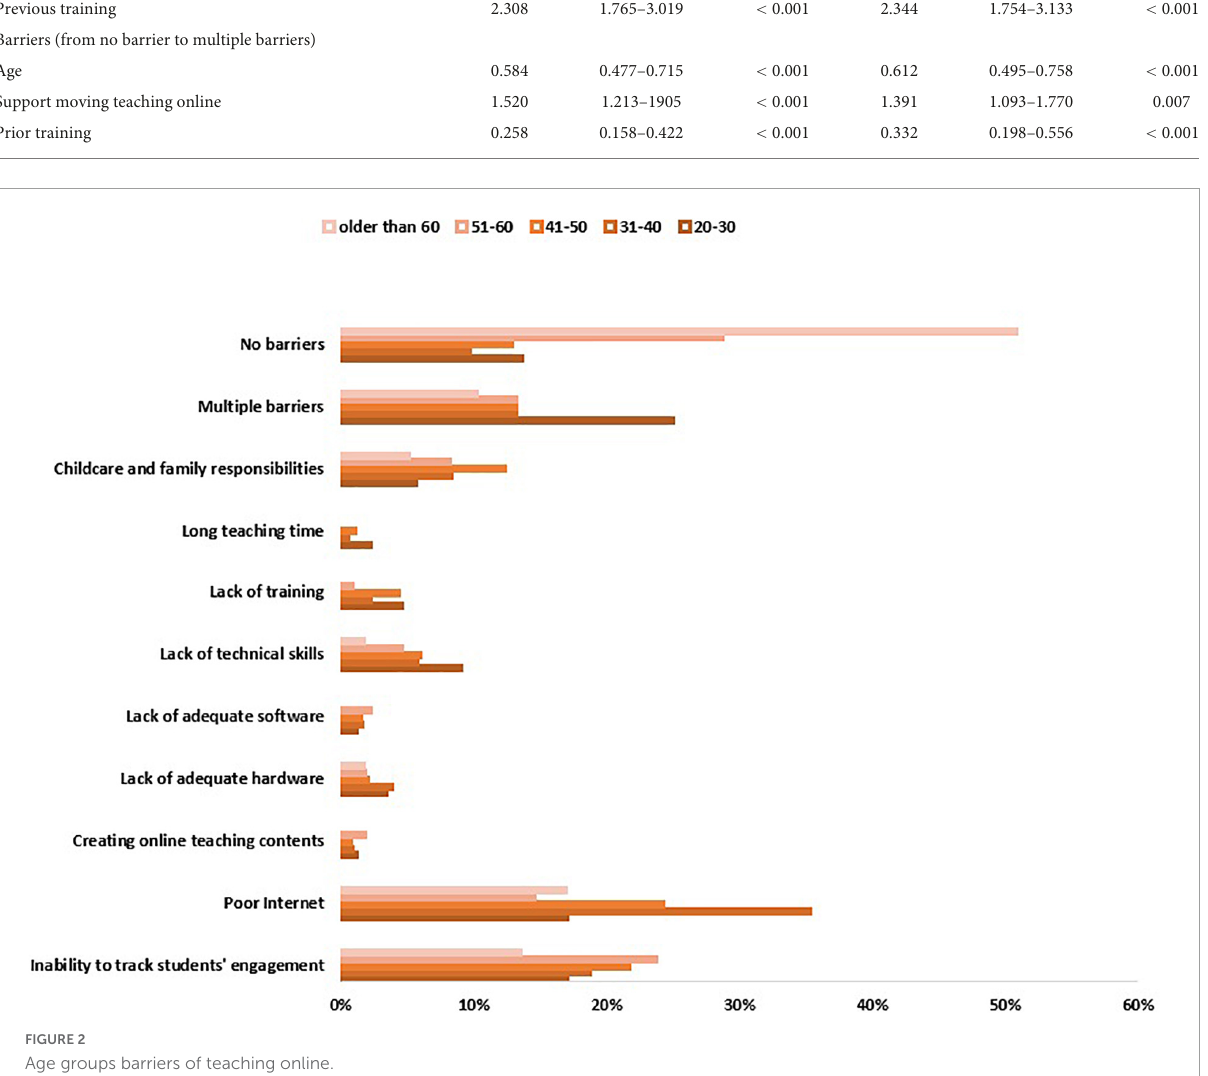
FIGURE2 Age groups barriers of teaching